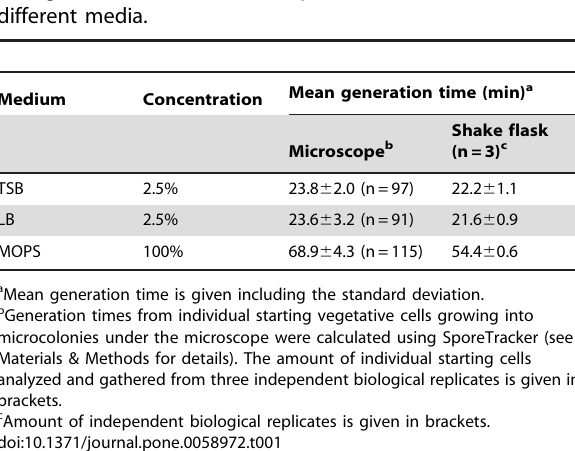
Table 1. Mean generation time of B. subtilis 1A700 vegetative cells grown under the microscope and in shake flasks in different